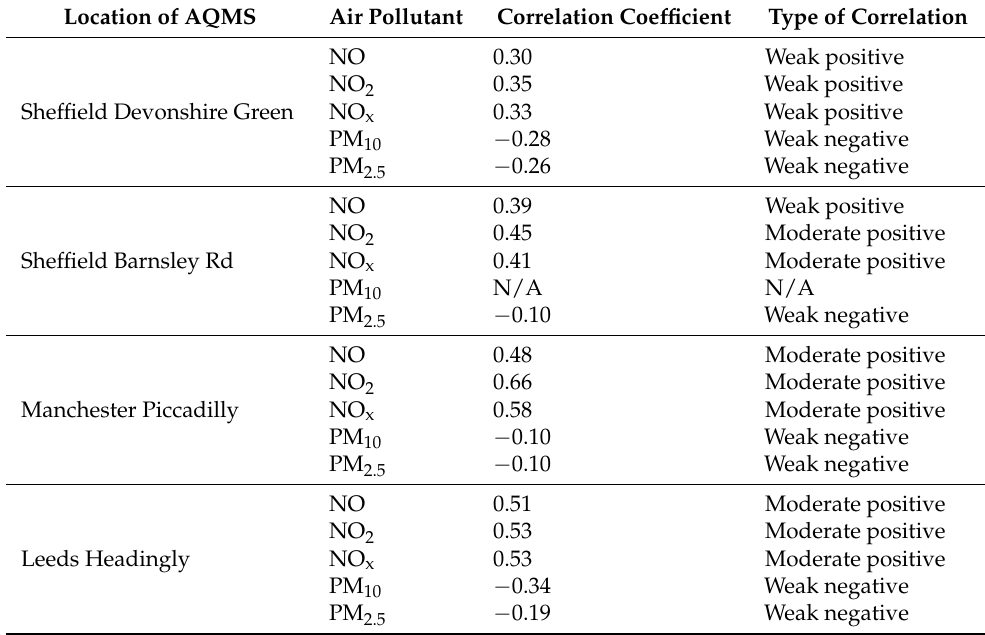
Table 5. Correlation analysis between mobility data and air pollutant concentrations at different monitoring stations during the lockdown period. Location of AQMS Air Pollutant Correlation Coefficient Type of